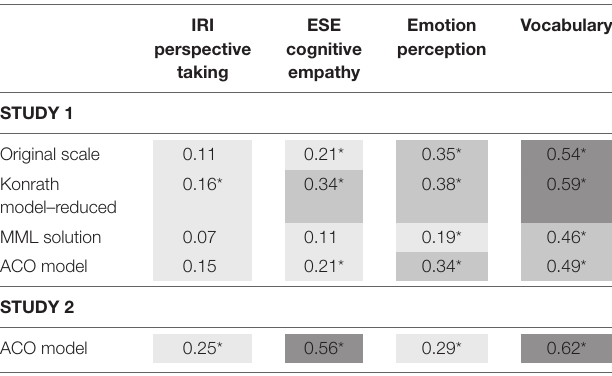
TABLE 7 | Study 1 and 2: correlations of the eyes test with the latent constructs cognitive empathy, vocabulary, and emotion perception. IRI